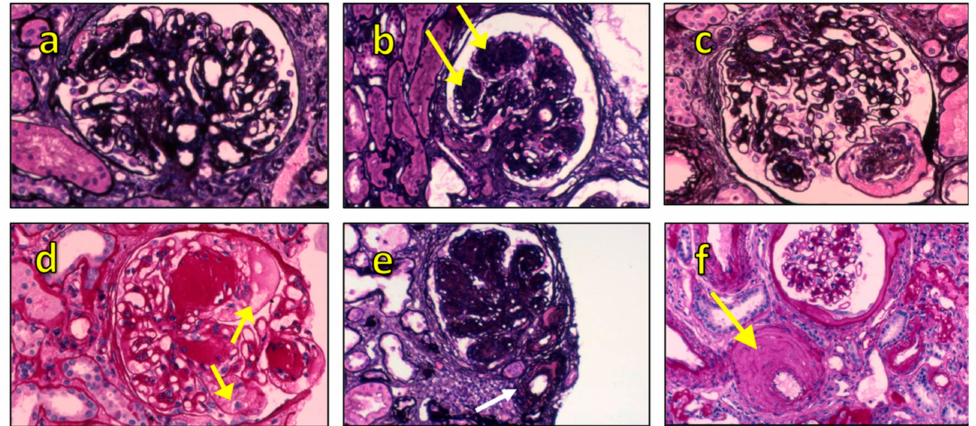
Figure 2. Morphological spectrum of diabetic nephropathy: ( a ) diffuse mesangial sclerosis. Periodic Schiff-Methenamine (PASM) staining 400 × ; ( b ) nodular glomerulosclerosis (arrows), also called Kimmelstiel–Wilson nodules. PASM staining 400 × ; ( c ) disintegration of mesangial matrix which presents fibrillar aspects. First step of nodule formation. PASM staining 400 × ; ( d ) glomerular microaneurysms (arrows) may arise in association with mesangiolysis due to a loss of anchoring points between GBM and the mesangium. PASM staining 400 × ; ( e ) afferent and efferent glomerular hyalinosis at vascular pole (arrow). Often present in diabetes, but not specific. PASM staining 200 × ; ( f ) Intimal fibrosis with reduplication of elastic lamina (arrow). PASM staining 200 × . Images by D.S.